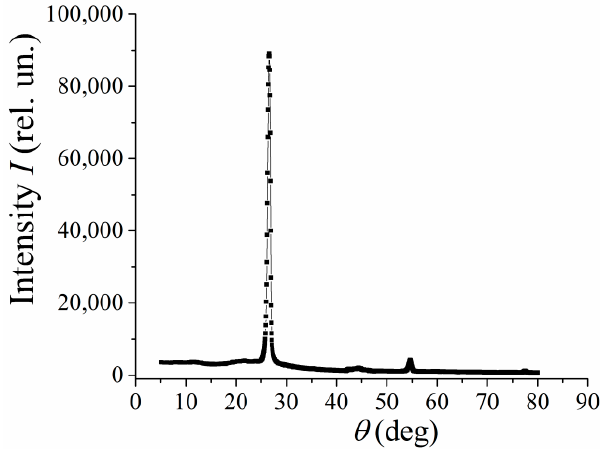
Figure 2. X ‐ ray diffraction analysis of multilayered graphene particles. Figure 2. X-ray diffraction analysis of multilayered graphene particles.